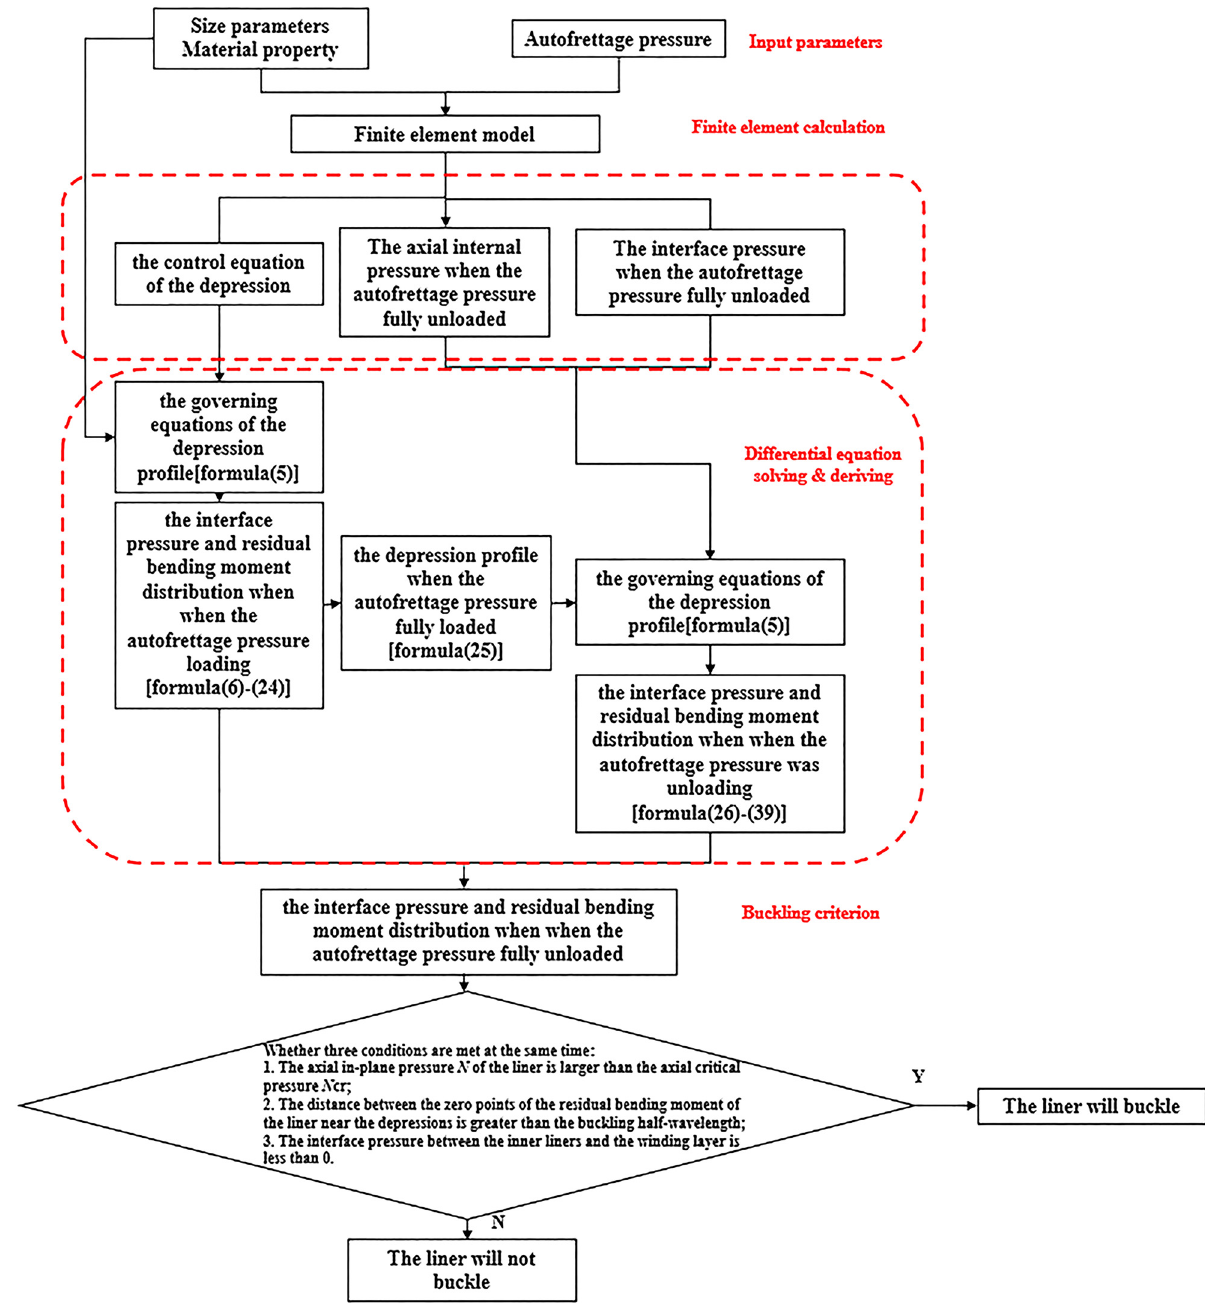
Figure 3: Calculation